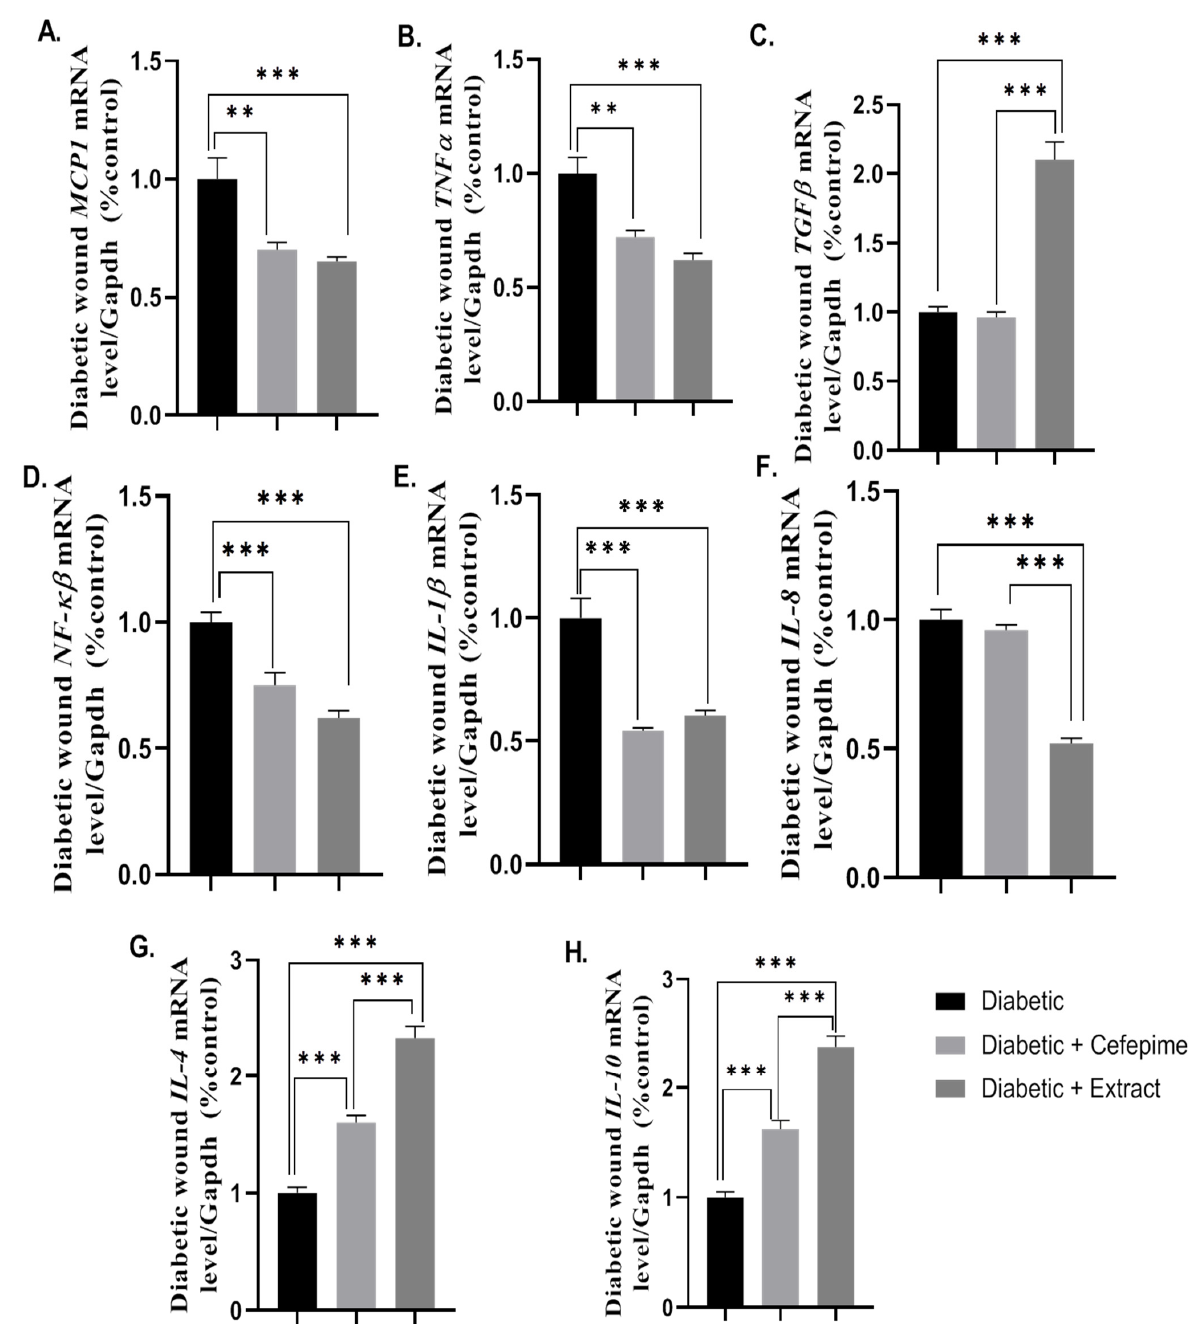
Figure 7. Effect of the hydrogel topical application of cefepime and CFE once daily for 14 successive days on the mean fold change of the mRNA relative expression of inflammatory and anti-inflammatory markers to internal control gene Gapdh of the diabetic wound infected with P. Mirabilis in type 1 diabetic rats ( A – H ). ( A ): mRNA relative expression of MCP1 to internal control gene Gapdh , ( B ): mRNA relative expression of TNF- α to internal control gene Gapdh , ( C ): mRNA relative expression of TGF- β to internal control gene Gapdh, ( D ): mRNA relative expression of NF- κβ to internal control gene Gapdh , ( E ): mRNA relative expression of IL-1 β to internal control gene Gapdh , ( F ): mRNA relative expression of IL-8 to internal control gene Gapdh, ( G ): mRNA relative expression of IL-4 to internal control gene Gapdh , and ( H ): mRNA relative expression of IL-10 to internal control gene Gapdh . *** Distinctive difference; ** Moderate difference; * Scant difference.